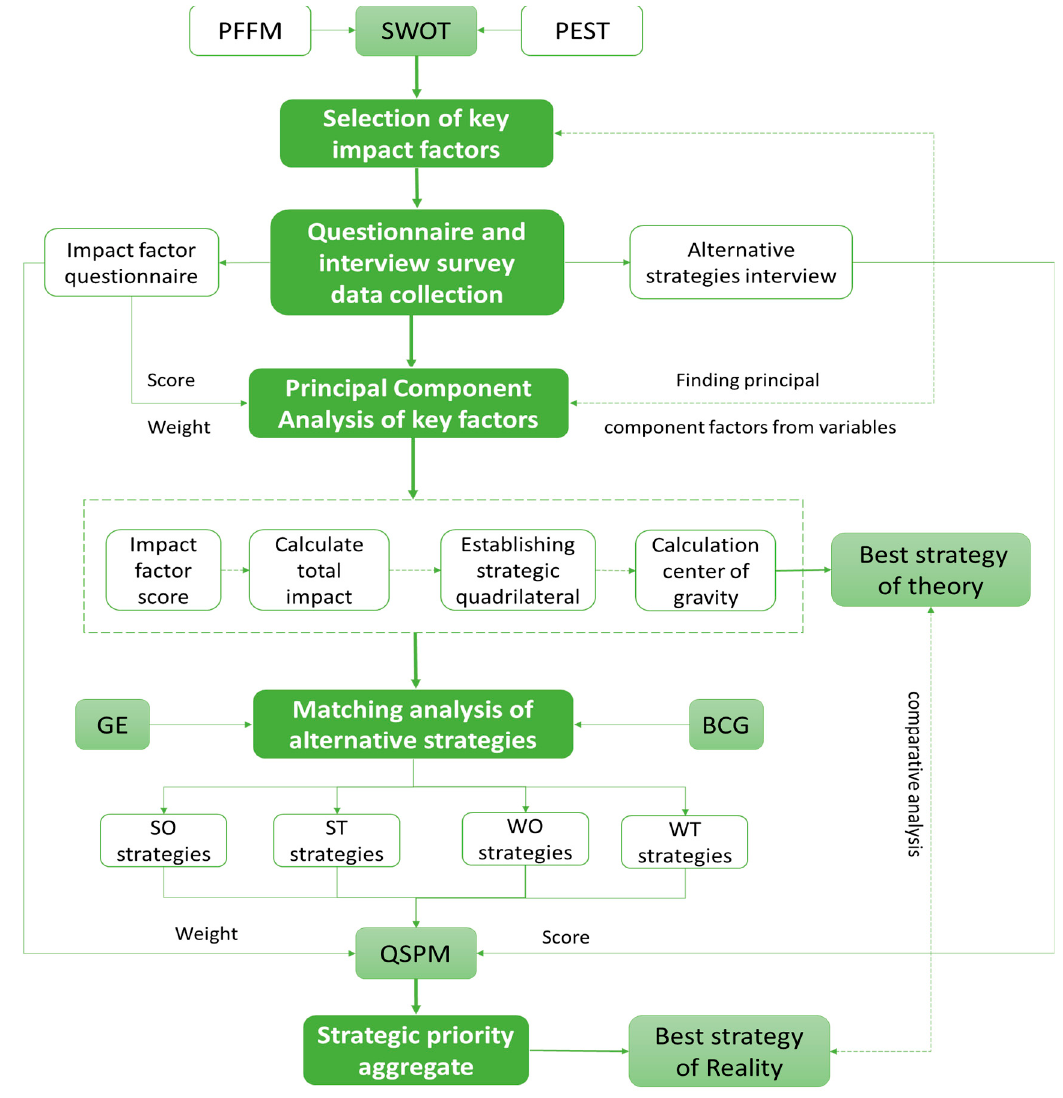
Figure 7. Research steps.